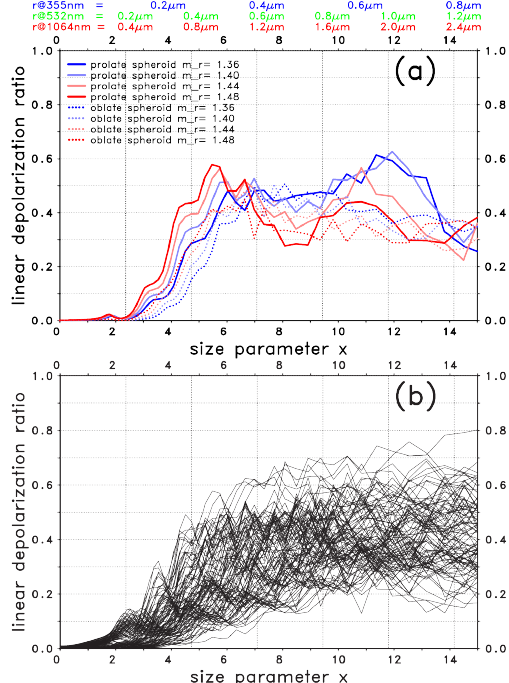
Figure 1. Linear depolarization ratio of non-absorbing oblate and prolate spheroids with m r equal to 1.36, 1.40, 1.44, and 1.48 as a function of size parameter, x . The upper panel (a) considers only aspect ratio 1.6, whereas the lower panel (b) considers aspect ratios from 1.2 to 5.0; for reference, the corresponding particle radii for the lidar wavelengths are also given above the top